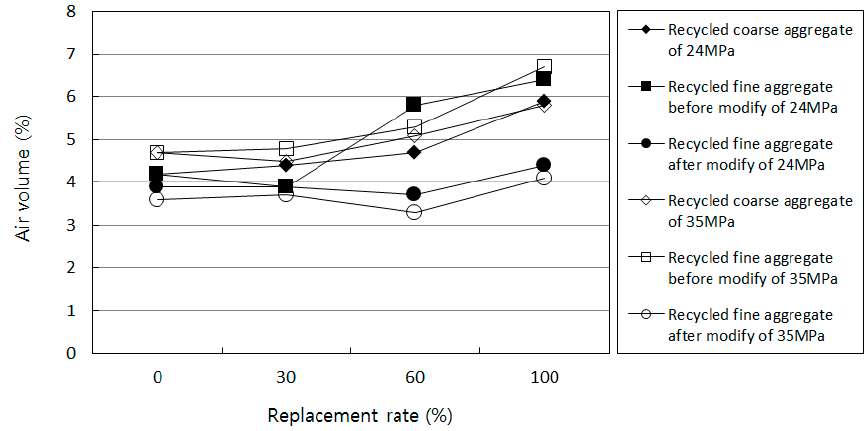
Figure 9. Air volume versus the replacement rate for each type of recycled aggregate for the general strength (24 MPa) and high strength (35 MPa) territory.